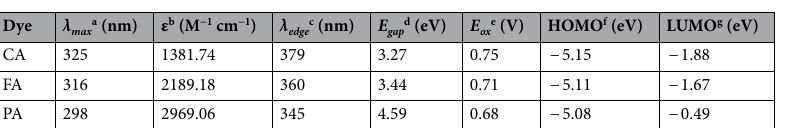
Table 1. Photophysical and electrochemical properties of CA, FA, and PA. a Absorption maximum in EtOH solutions (10 –5 M). b Molar extinction coefficient, calculated using Lambert–Beer’s law. c The onset of absorption spectra in EtOH solutions (10 –5 M). d E gap was estimated from the onset of the absorption spectra in EtOH, E gap = 1240/ λ edge . e E ox was measured by CV in EtOH and ferrocene was used as an external reference. f Calculated from HOMO = − (E g Calculated from LUMO = E ox + 4.4)eV. gap + HOMO.